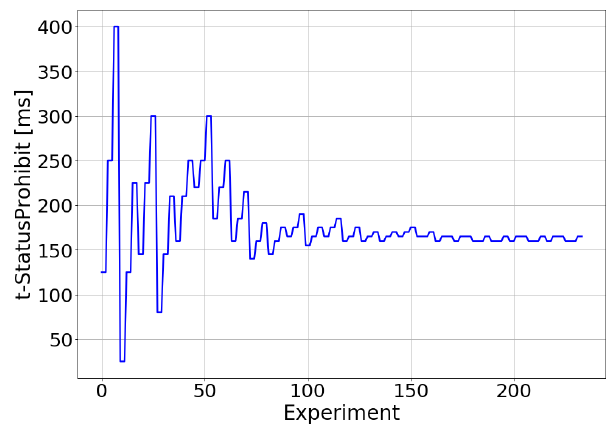
Figure 10. Real environment—t-StatusProhibit